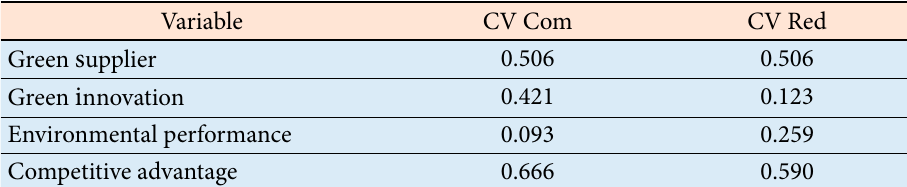
Table 3. Q 2 values for the latent variables